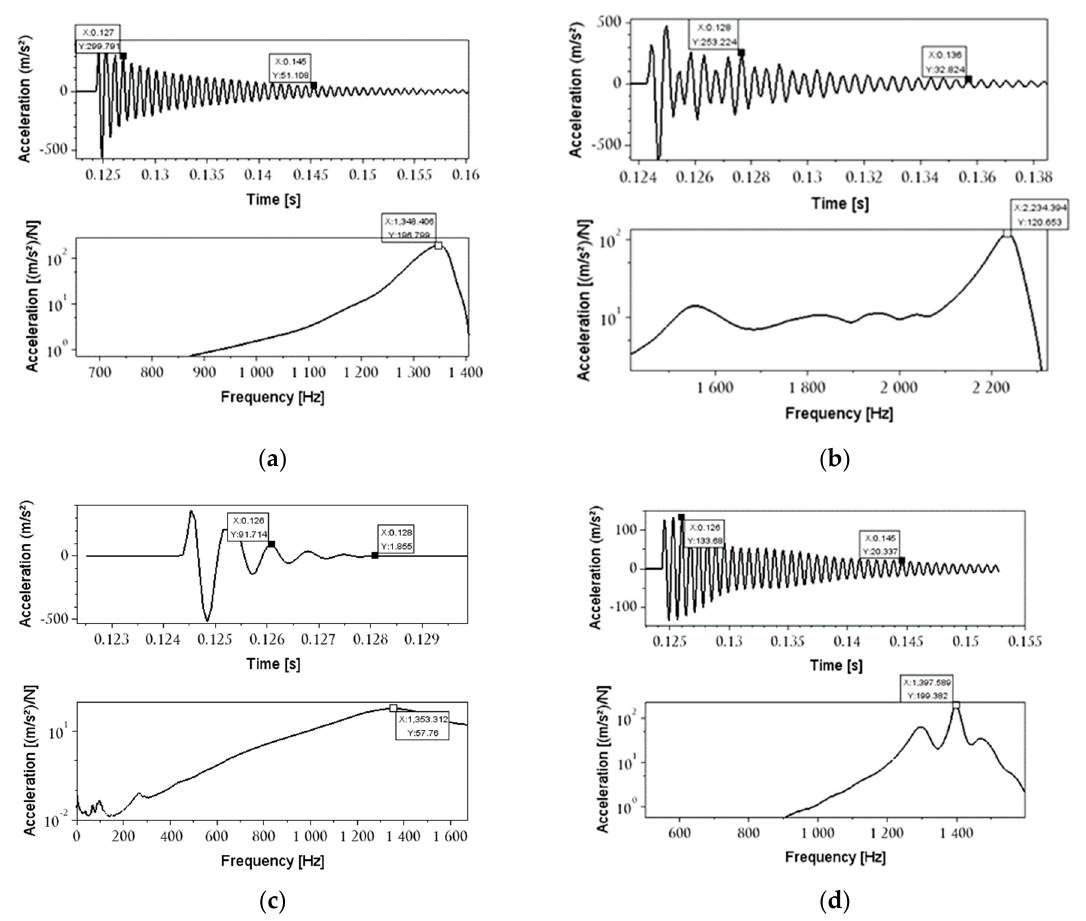
Figure 5. IRF and FRF for boring bars in TSC = 7.81 mm − 1 ( a ) standard boring bar; ( b ) carbide boring bar; ( c ) TMD boring bar; ( d ) ID boring